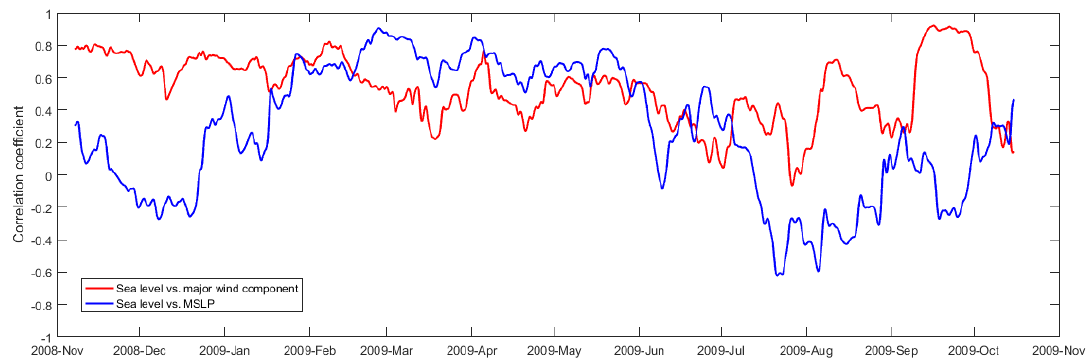
Figure 12. Correlation between low ‐ pass ‐ filtered sea ‐ level records and meteorological forcing including major wind component (red line) and MSLP (blue line).